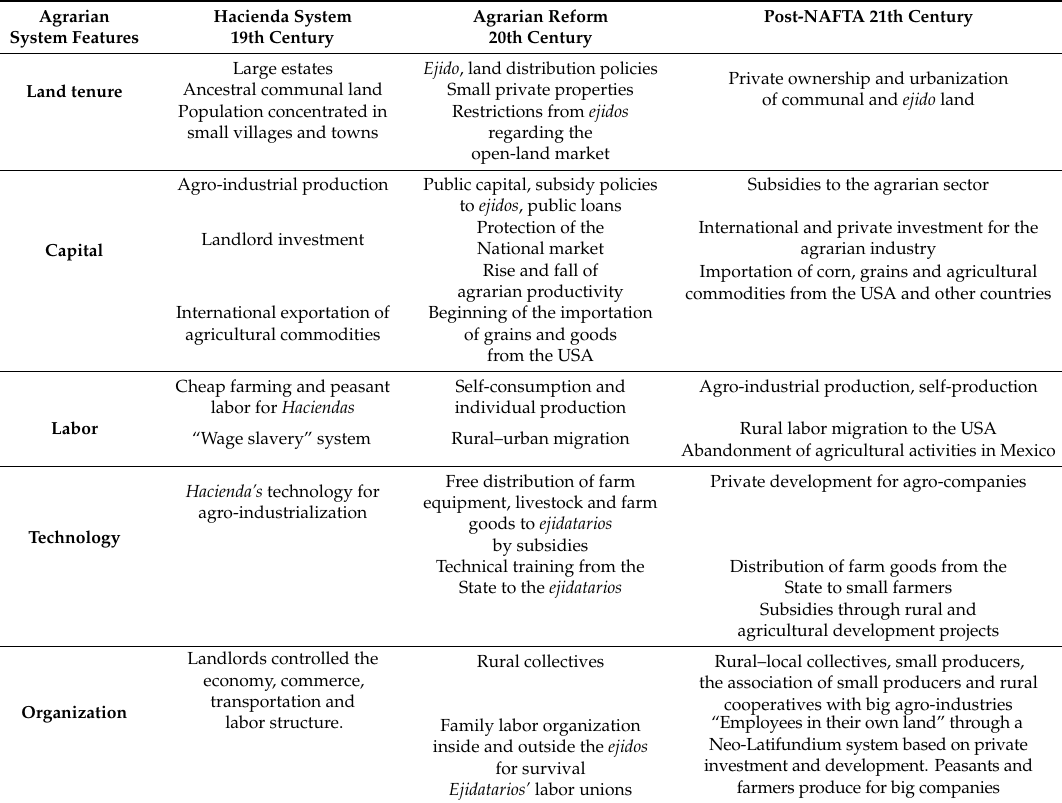
Table 1. Agrarian Change in Mexico. Source: Melissa Schumacher and Teodoro Schumacher. Agrarian System